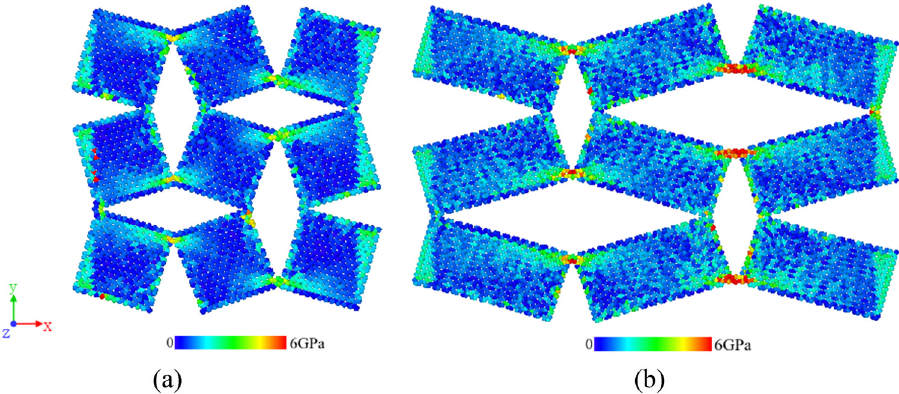
Figure 9: von Mises stress distribution of structure with strain of 0.05: ( a ) b = 3 nm; ( b ) b = 6 nm.